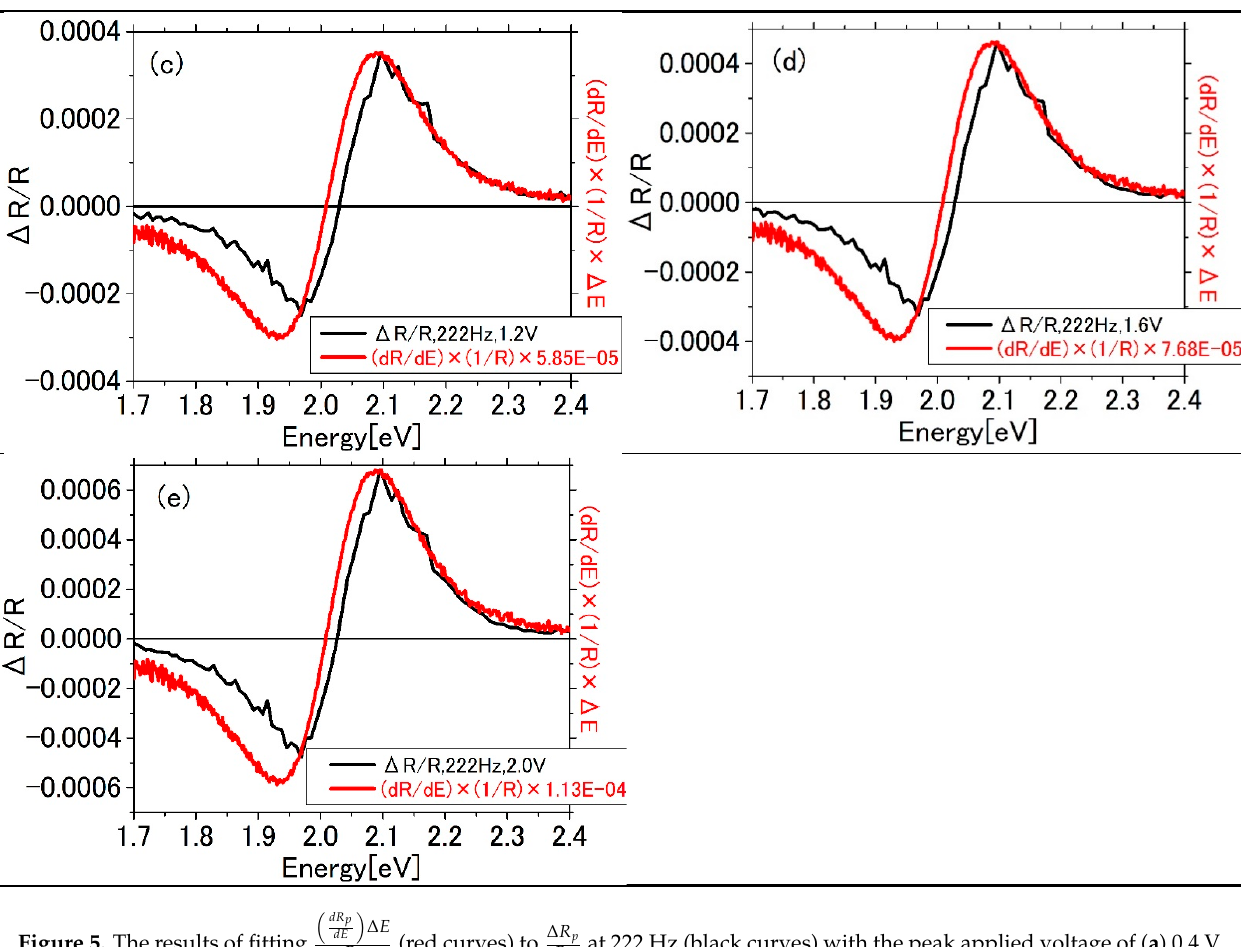
Figure 5. The results of fitting V, ( b ) 0.8 V, ( c ) 1.2 V, ( d ) 1.6 V, and ( e ) 2.0 V. Here, the signal dominates.